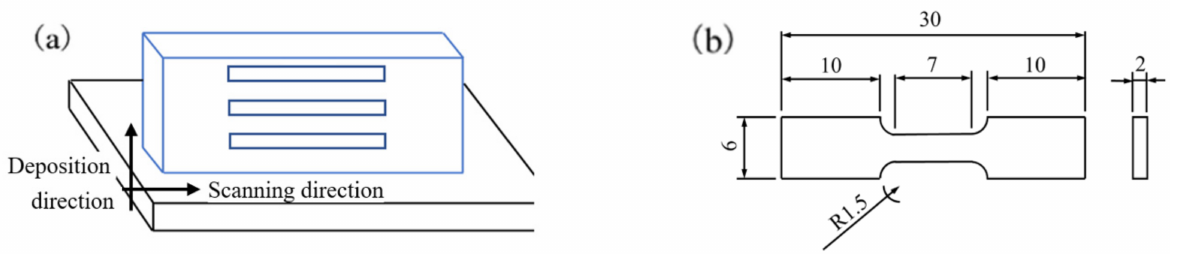
Figure 10. Sampling position and size of tensile samples. ( a ) Sampling position of tensile samples. ( b ) Sampling size of tensile samples.